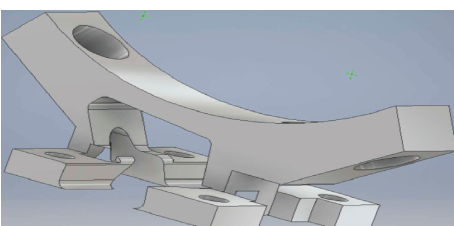
Figure 12: 3D topology optimized compliant robotic – 42% volume